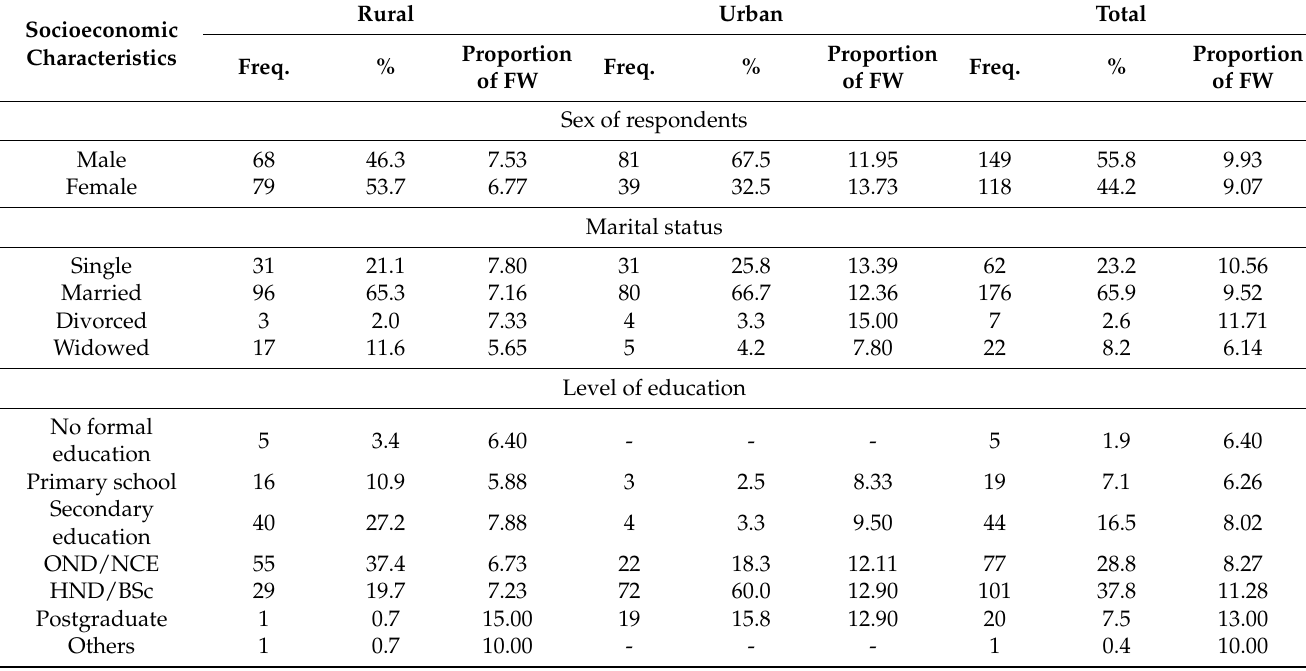
Table 1. Socioeconomic characteristics and the proportion of food waste per month by